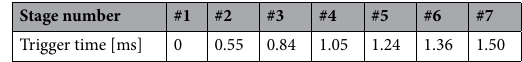
Table 2. Timing of the stages